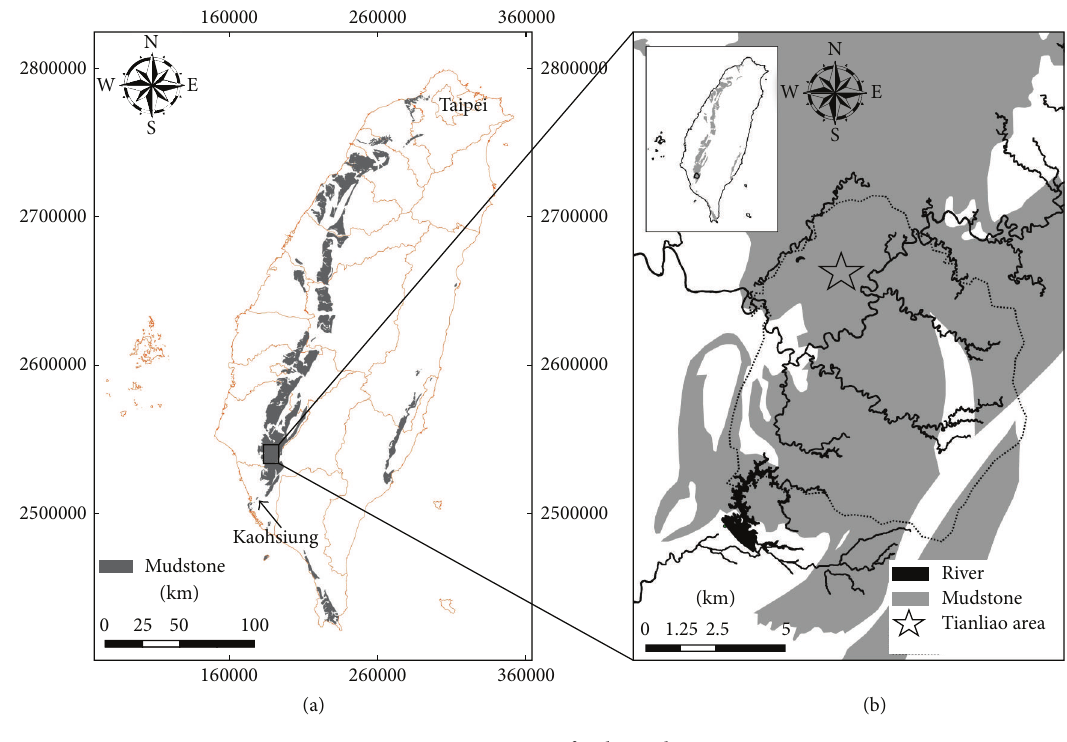
Figure 1: Location of soil